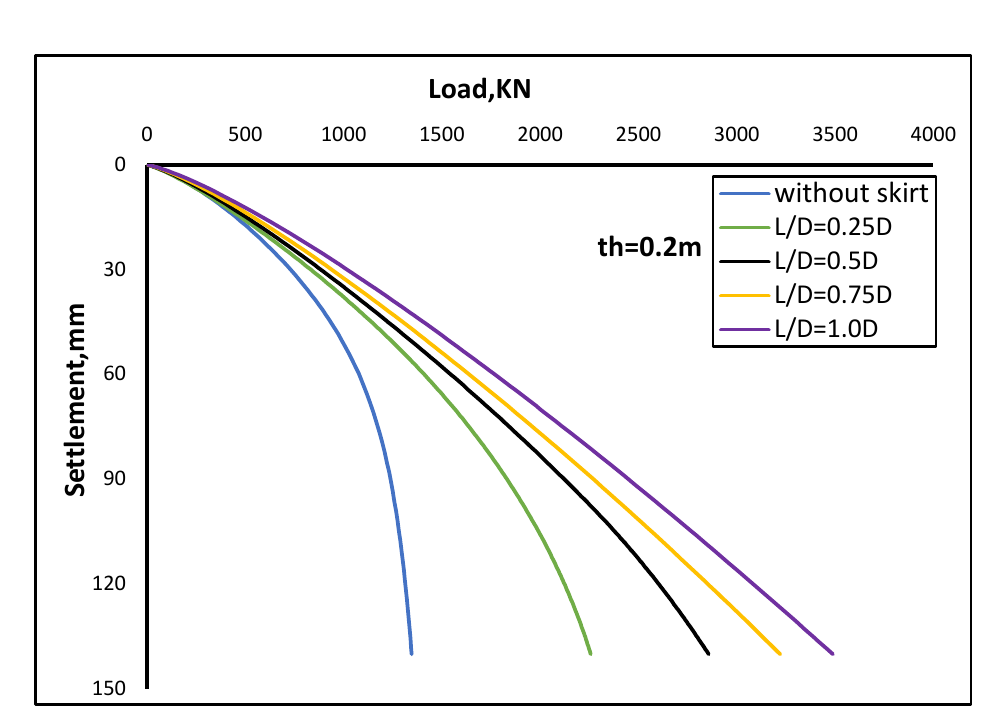
Fig. 7. Load-settlement relationship for skirt circular footing, different